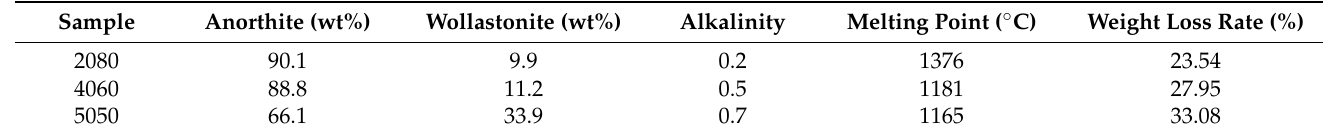
Table 5. Property parameters of the